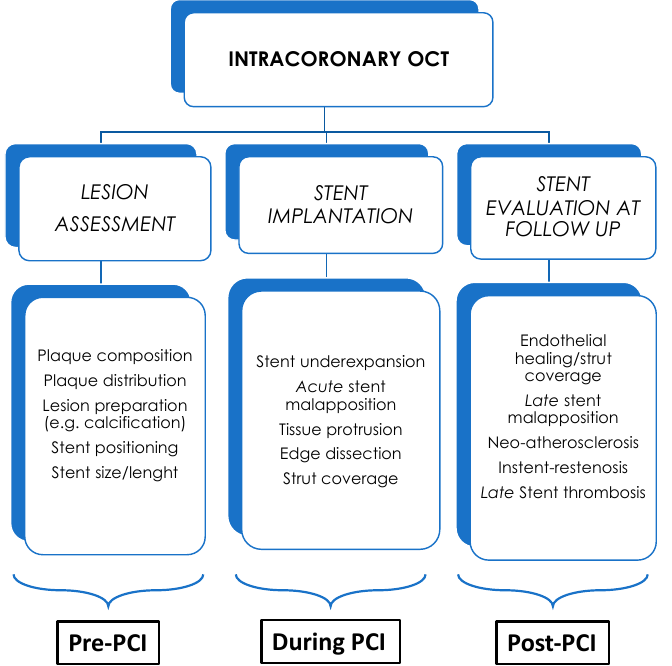
Figure 2. Intracoronary OCT guided optimization of percutaneous coronary intervention (PCI).